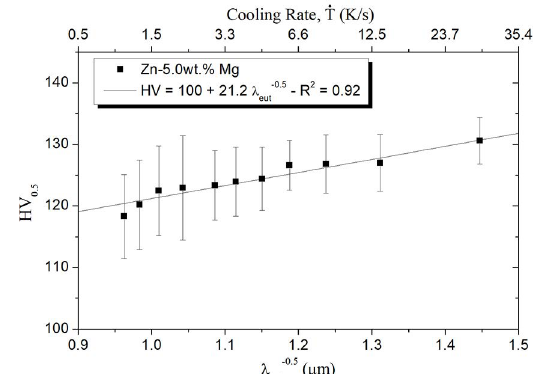
) as a function of the 0.5 ) and cooling rate eut